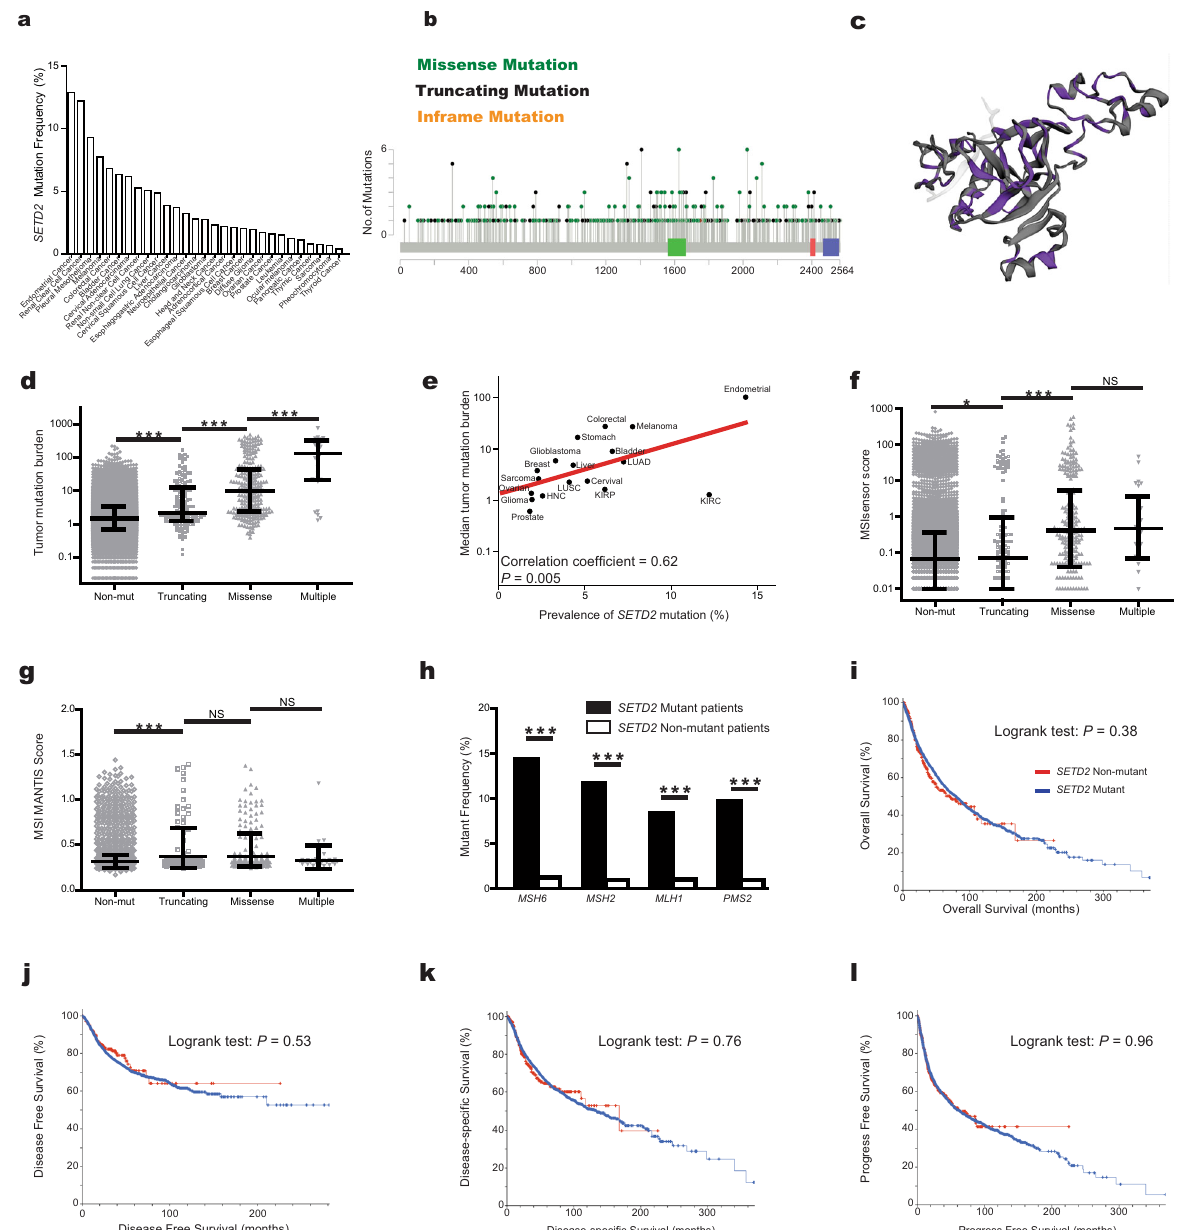
Fig. 1 The characteristics of SETD2 mutations in TCGA pan-cancer cohort. a The prevalence of SETD2 mutations across tumors. b The subtypes and distributions of SETD2 somatic mutations. X -axis, amino acid; Y -axis, numbers of SETD2 mutations; green box, SET domain (1561 – 1667); red box, WW domain (2391 – 2420); blue box, SRI domain (2466 – 2558); green dot, missense mutation; black dot, truncating mutation; orange dot, inframe mutation. c Location of variants on the 3D protein structure of SETD2. Purple, mutated amino acid. d Tumor mutation burden (TMB) in SETD2 nonmutant cancer and different subtypes of SETD2 mutant cancer. Each gray dot represents one patient, black line represents the median TMB and its interquartile ranges. e The prevalence of SETD2 mutation and median TMB in multiple tumors. Red line, fi tted curve; HNC, head and neck cancer; LUAD, lung adenocarcinoma; LUSC, lung squamous cell carcinoma; KIRC, kidney renal clear cell carcinoma; KIRP, kidney renal papillary cell carcinoma. f MSIsensor scores in SETD2 nonmutant cancer and different subtypes of SETD2 mutant cancer. g MSI MANTIS scores in SETD2 nonmutant cancer and different subtypes of SETD2 mutant cancer. h The mutant frequencies of MSH2, MSH6 , MLH1 , and PMS2 in SETD2 mutant and nonmutant cancer. i Overall survival (OS) analysis strati fi ed by SETD2 mutation status in the whole TCGA cohort. j Disease-free survival (DFS) analysis strati fi ed by SETD2 mutation status in TCGA. k Disease-speci fi c survival (DSS) analysis strati fi ed by SETD2 mutation status in TCGA. l Progress-free survival (PFS) analysis strati fi ed by SETD2 mutation status in TCGA. NS, P > 0.05; * P < 0.05; *** P <